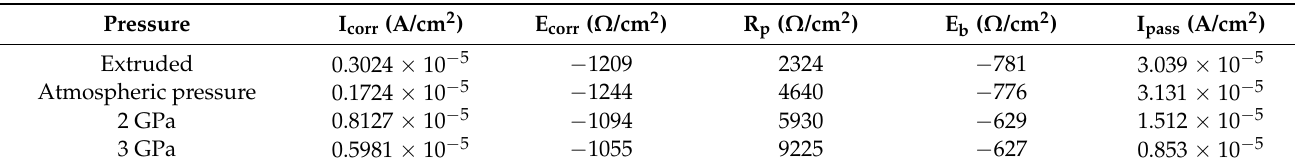
Table 4. Results of the polarization experiments for the extruded Al-Zn-Mg-Cu alloy annealed at different pressures measured in 3.5% NaCl